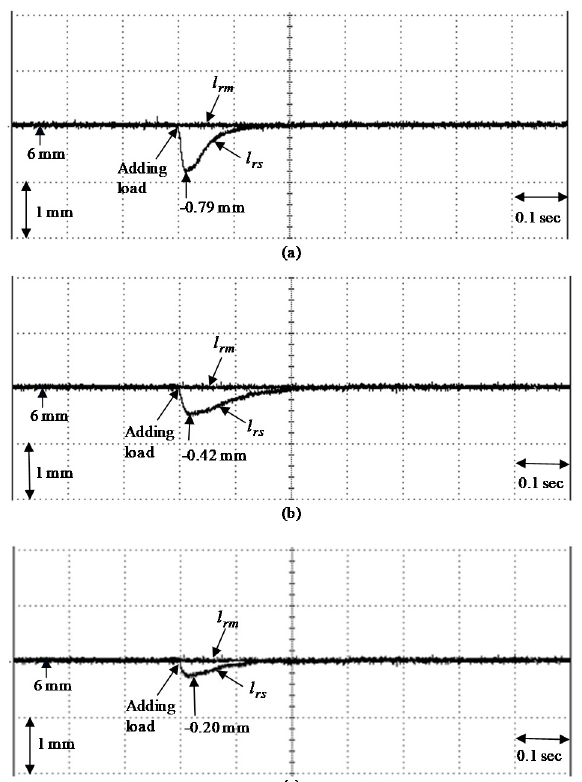
Figure 14. Tested results at Situation Q5: ( a ) mover position-regulating response utilized by the control system K1, ( b ) mover position-regulating response utilized by the control system K2; ( c ) mover position-regulating response utilized by the control system K3.